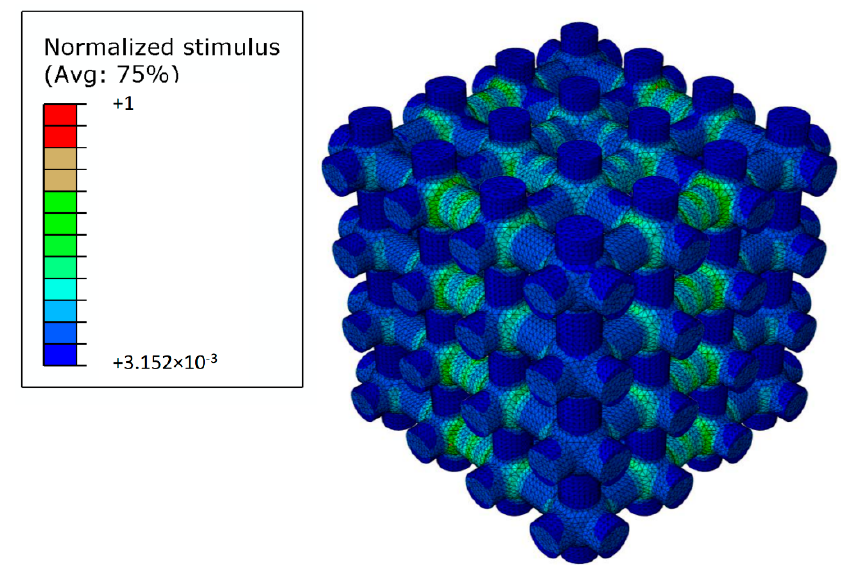
Figure 9. Spatial distribution of the normalized biophysical stimulus S / S max computed for a scaffold ( D s = 0.425 mm D c = 0.275 mm) subjected to the compression load of F UA = 0.5 MPa.